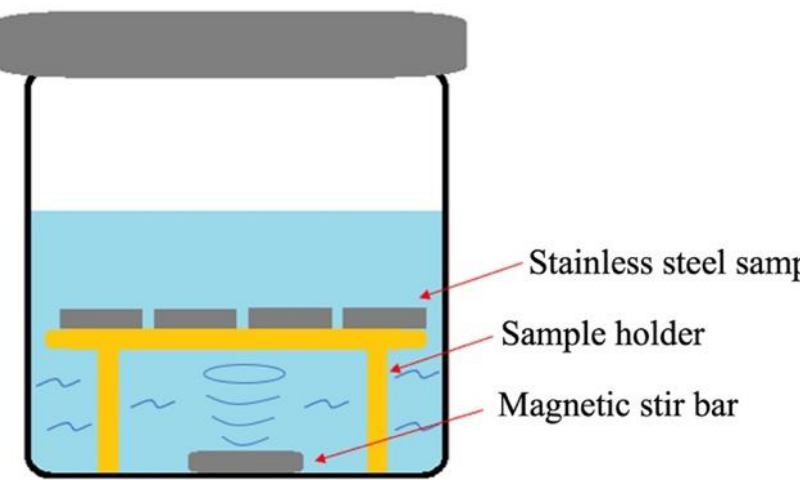
Figure 3. Schematic representation of experimental setup employed for sol – gel process.